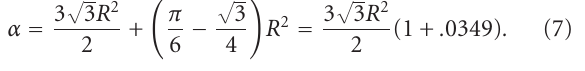
√ 3 R 2 / 2 creates uncovered region